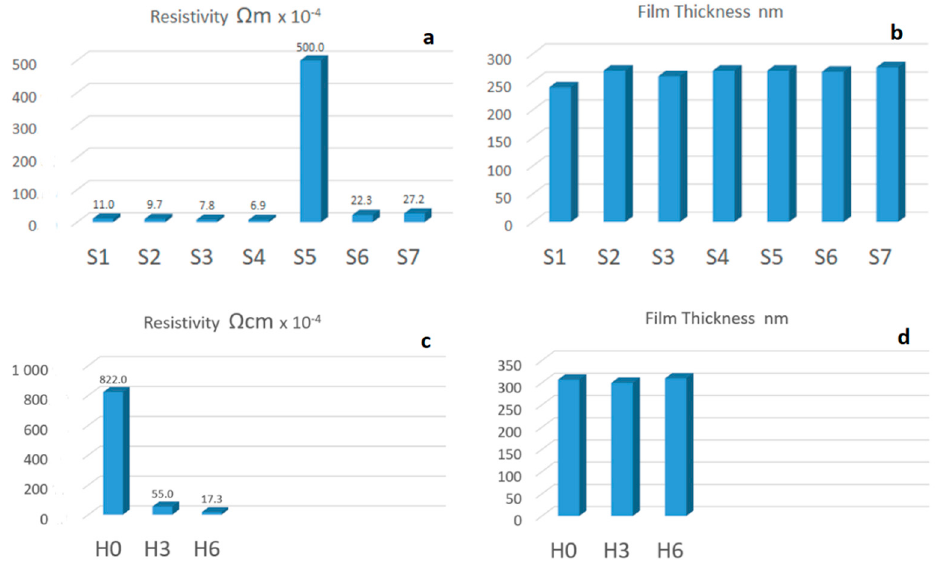
Figure 6. ( a ) The resistivity of the films obtained using the Hall-effect measurement technique demonstrates that each consecutive deposition process under Ar + H gas gradually improves the electrical conductivity of the films, while the S5 sample, deposited during the transition from Ar + H to Ar gas, shows poor results. ( b ) The thickness of the films does not show a significant difference, however, the first sample deposition, where the target was first exposed to hydrogen, demonstrates a lower yield. ( c ) Prolonged exposure to Ar + H gas in improving the resistivity of ZnO based samples. ( d ) All ZnO samples demonstrate similar film thickness. Coatings 2019 , 9 , x FOR PEER REVIEW